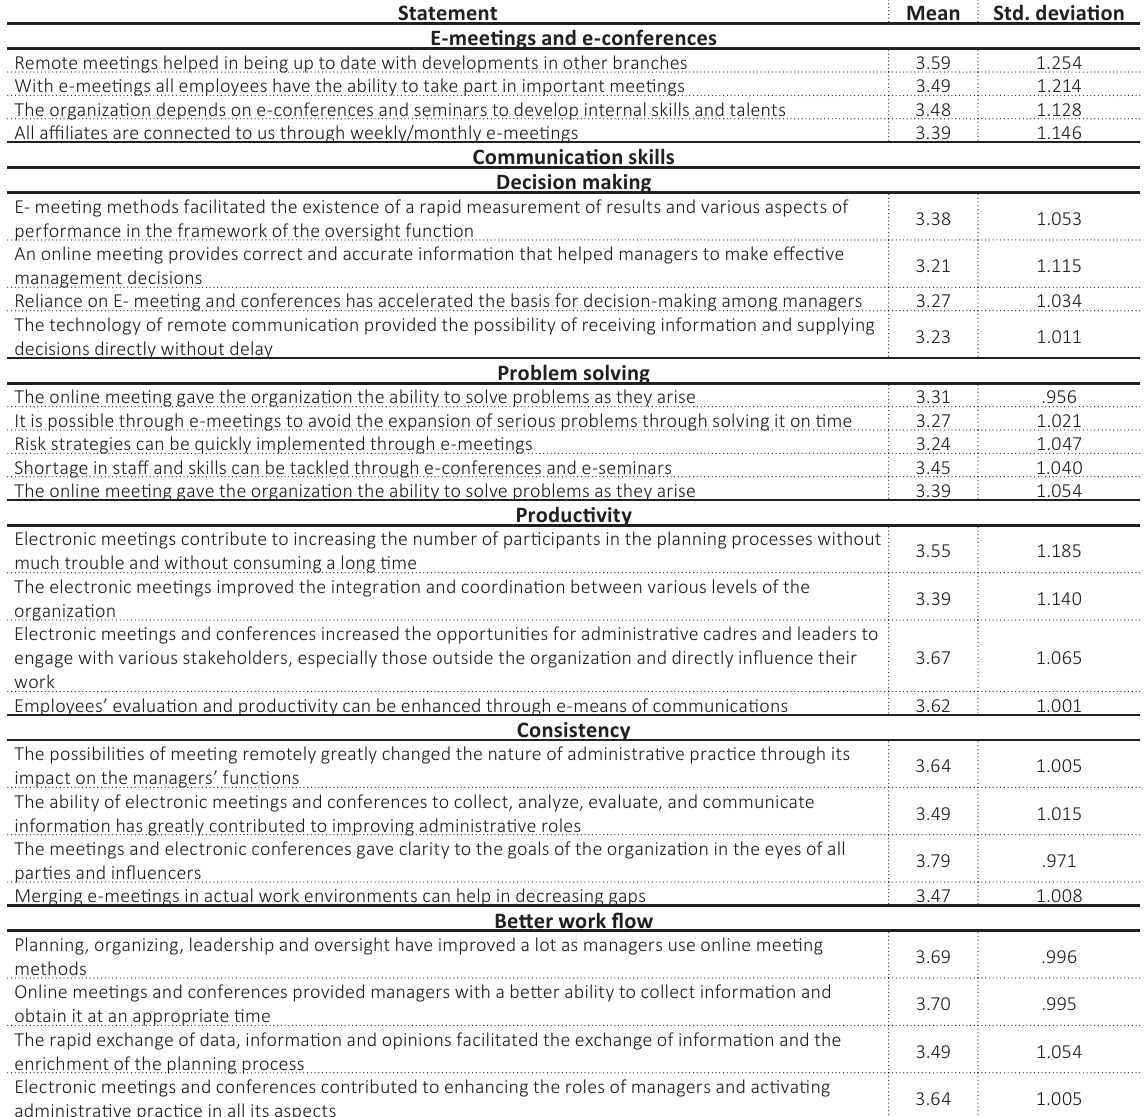
Table 5. Descriptive analysis of questionnaire statements